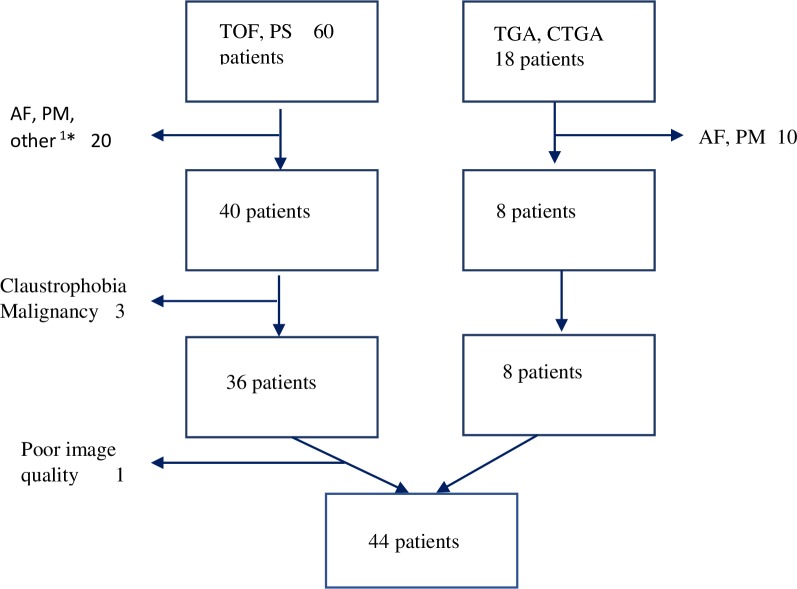
CONSORT flow chart for the inclusion and exclusion of study participants.1* inability to cooperate, AF atrial fibrillation, PM Pacemaker, TGA Transposition of the Great Arteries, CCTGA congenitally corrected transposition of the Great Arteries, TOF Tetralogy of Fallot, PS pulmonary stenos.